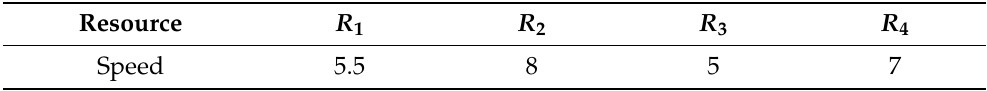
Table 2. Data for the Example Instance